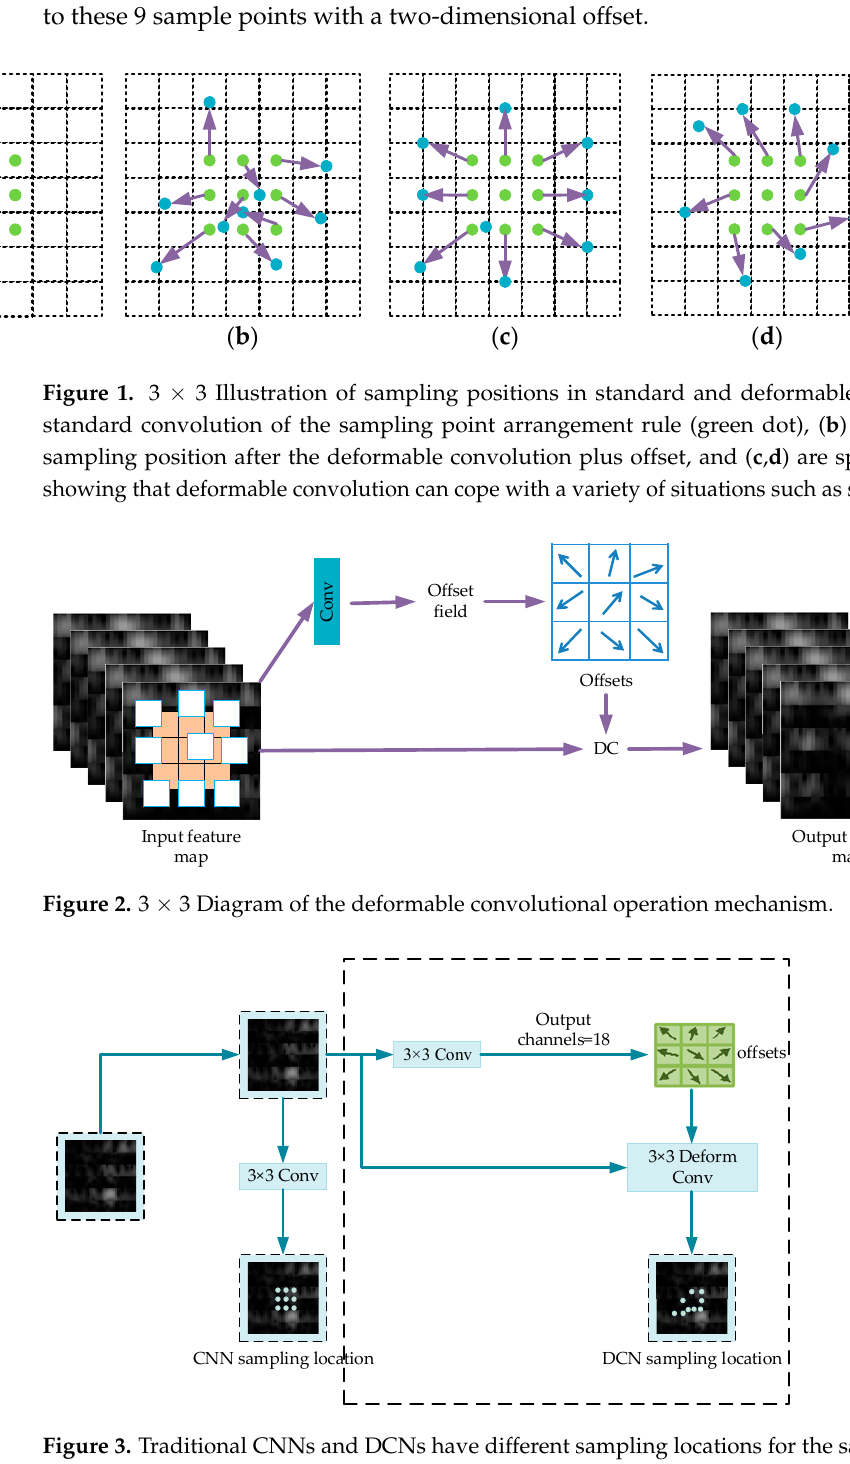
Figure 3. Traditional CNNs and DCNs have different sampling locations for the same area.